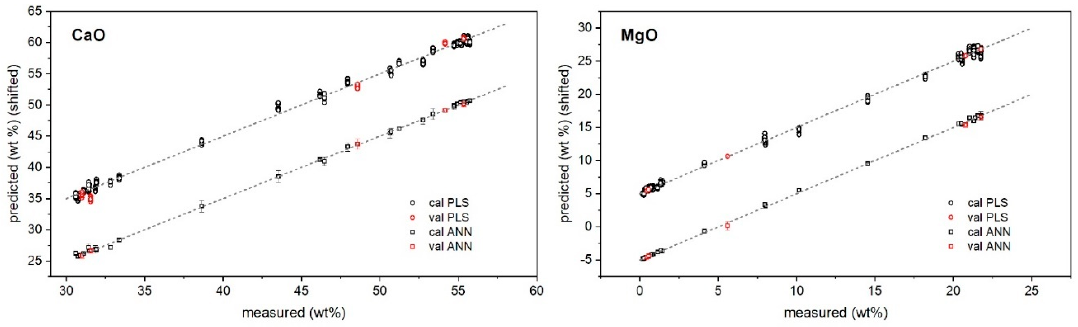
Figure 2. PLS and ANN predicted vs. reference concentrations of major oxides. Plots are vertically shifted for better clarity: ± 5 (+PLS, − ANN).